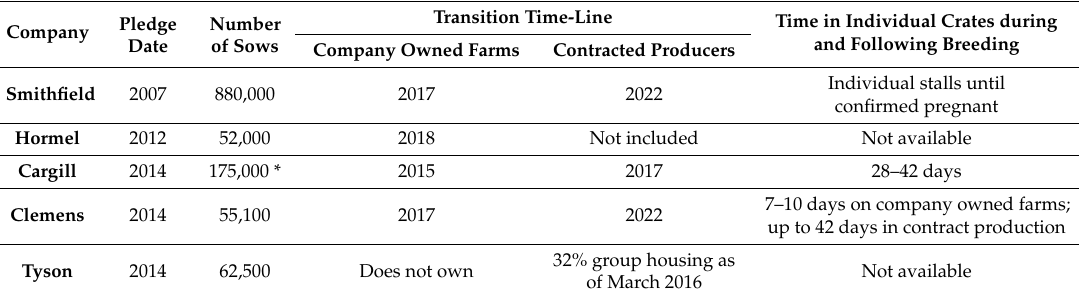
Table 1. Producer group housing pledges [93–100], including the total number of company-owned, company-managed and contract produced sows